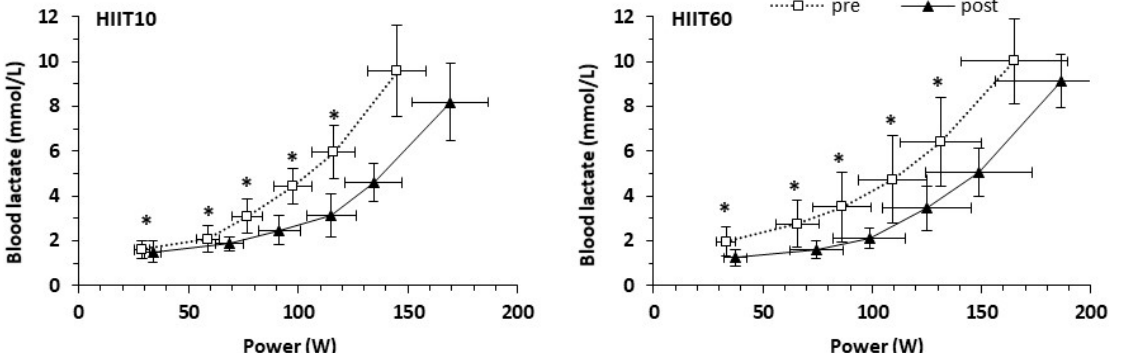
Figure 3. Blood lactate concentration during a progressive submaximal test before (pre) and after (post) training for the HIIT10 and the HIIT60 groups. * p < 0.05 for pre- vs. post-training. Points represent means, and error bars represent SD. VO 2 , oxygen uptake.